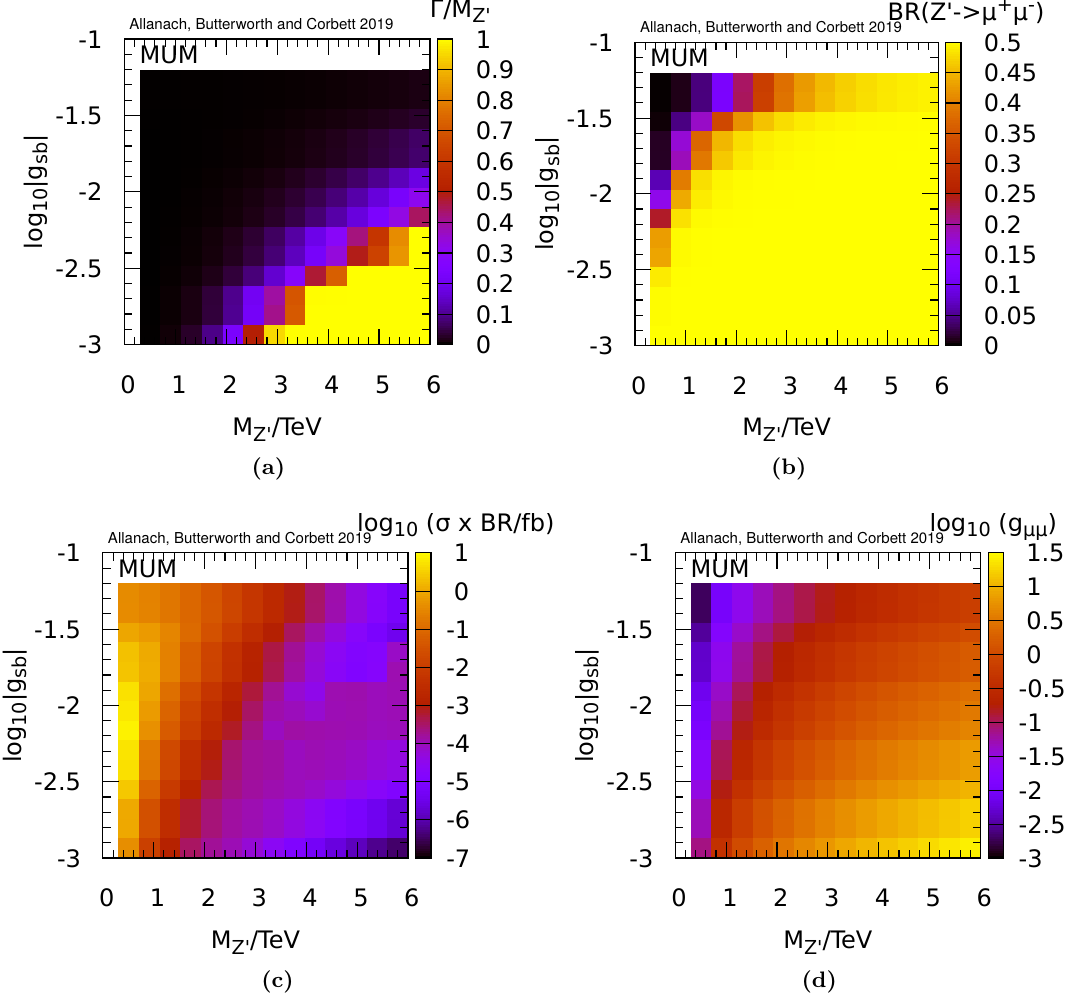
Figure 7 . Properties of the central (cid:12)t of the MUM model to NCBAs. In (a), we show the Z 0 width divided by its mass, (cid:0) =M Z 0 . In (b), the branching ratio into di-muons is shown, in (c) the (cid:12)ducial Z 0 production cross section multiplied by its branching ratio into di-muons is displayed. (d) shows g (cid:22)(cid:22) coming from the central (cid:12)t to